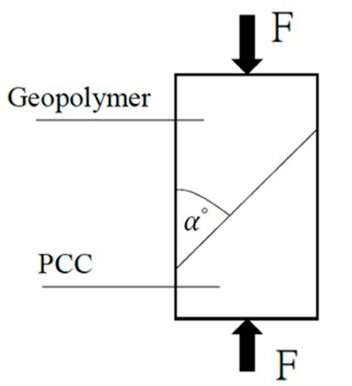
Figure 1. FGG slant shear test repair schematic.